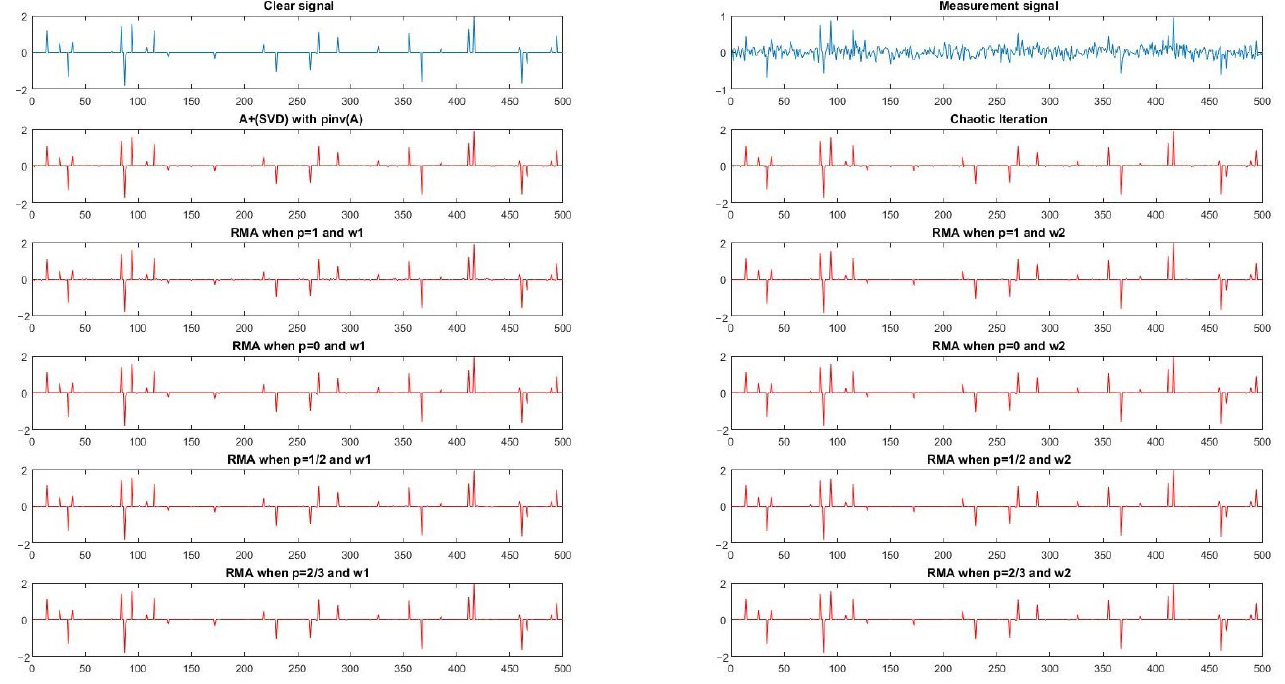
Figure 1. (m, n) = (250, 500).